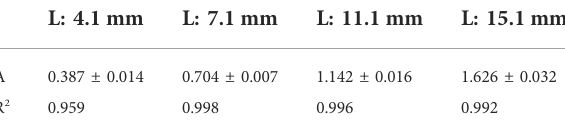
TABLE 4 The ampli fi cation constants A for balloon actuators with different chamber lengths were calculated by the exponential growth curve fi tting with high R 2